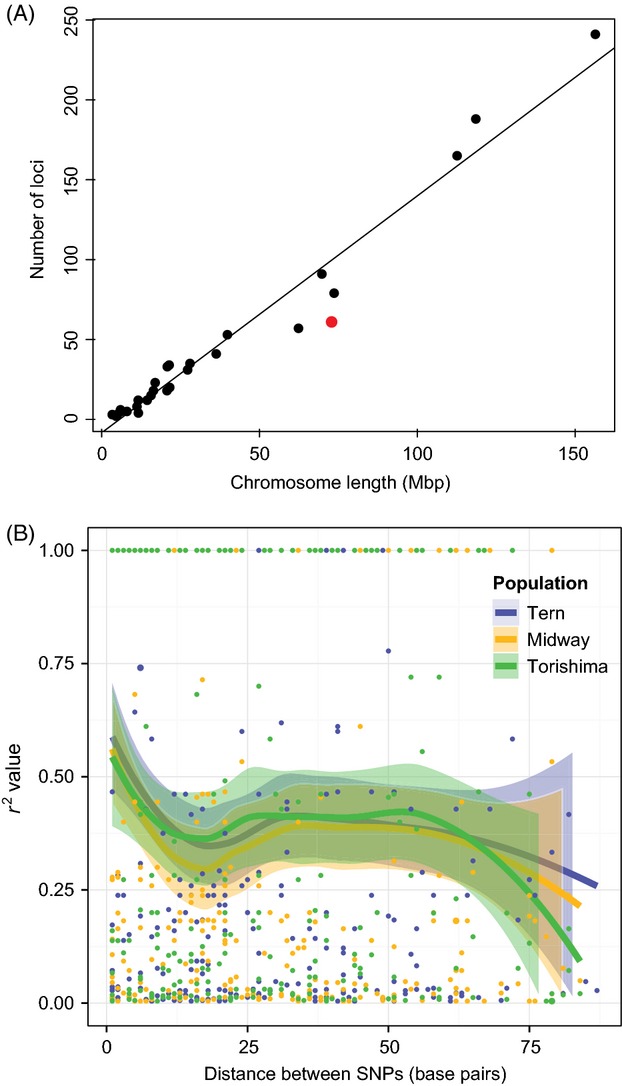
Panel A shows the chromosomal distribution of data set 1 single nucleotide polymorphisms (SNPs) as mapped to the Zebra Finch genome with an e-value <−10. Chromosome length is significantly correlated with the number of SNPs (R2 = 0.961, P-value <0.0001). The red dot corresponds to the Z chromosome loci. Panel B shows linkage disequilibrium as measured by r2 (Wakeley 2008) between pairs of SNPs found on the same RADseq locus. For eight randomly chosen individuals from each population, the LOESS smoothed r2 value (solid lines) plus 95% SE confidence intervals (Wickham 2009) are shown for each SNP distance.